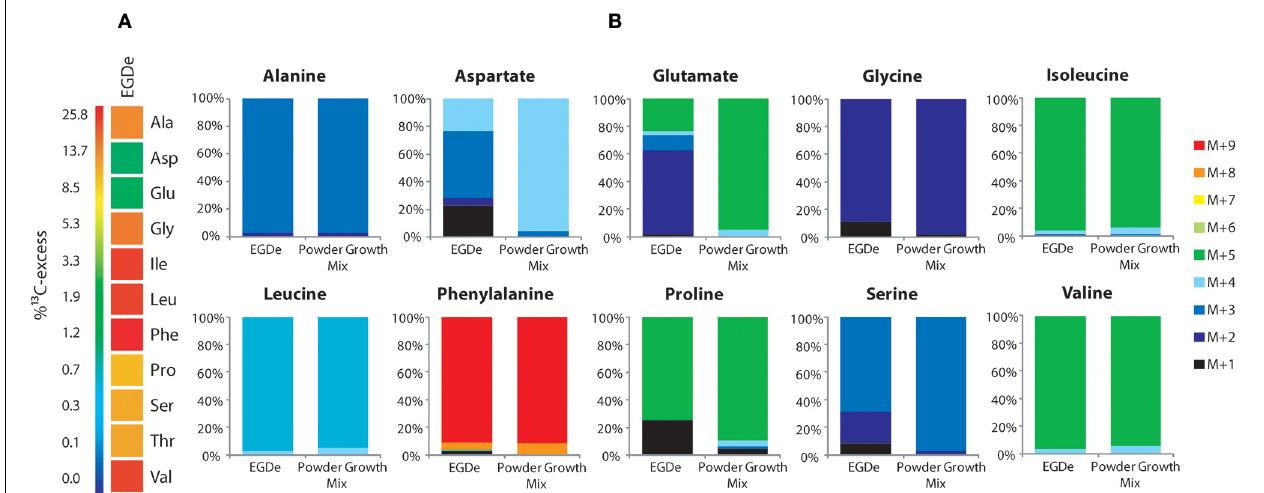
FIGURE 2 | Isotopologue profiling of protein-derived amino acids from L. monocytogenes grown in J774A.1 macrophages labeled with a mix of [U- 13 C]-amino acids. (A) 13 C-Excess (in %) of amino acids from L. monocytogenes EGDe wild-type. The color map indicates 13 C excess from 0 to 25% in quasi-logarithmic form. (B) Isotopologue profiles in listerial amino acids from the same experiment with EGDe